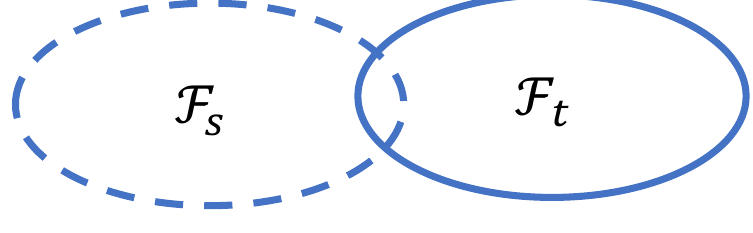
Figure 3. The overlap between the two domains regarding the states and actions.